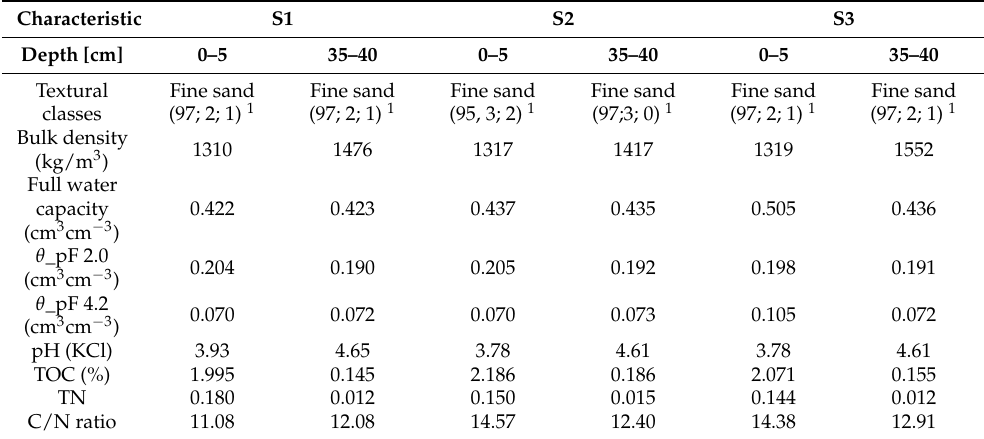
Table 1. Main properties of the top soils at the three study